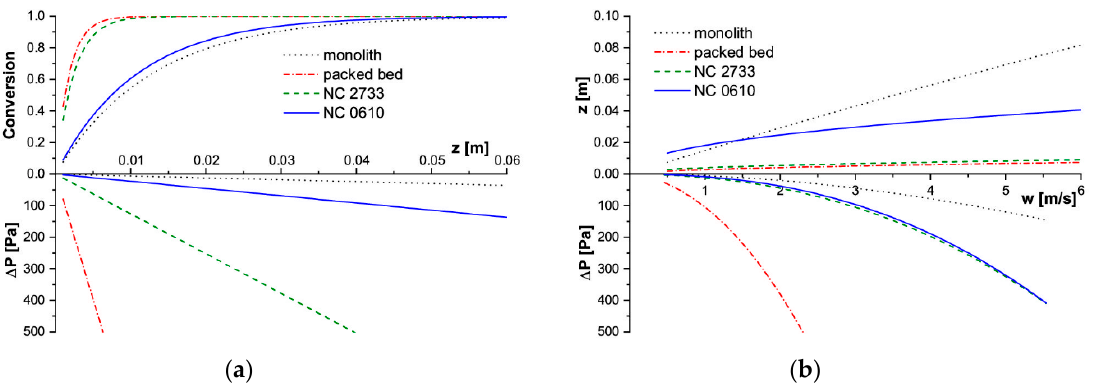
Figure 6. Modelling results for CH 4 combustion process in T = 773 K. ( a ) Conversion and pressure drop profiles along the reactor length for w = 2 m / s, ( b ) Reactor length and corresponding pressure drop for assumed conversion X = 90%.